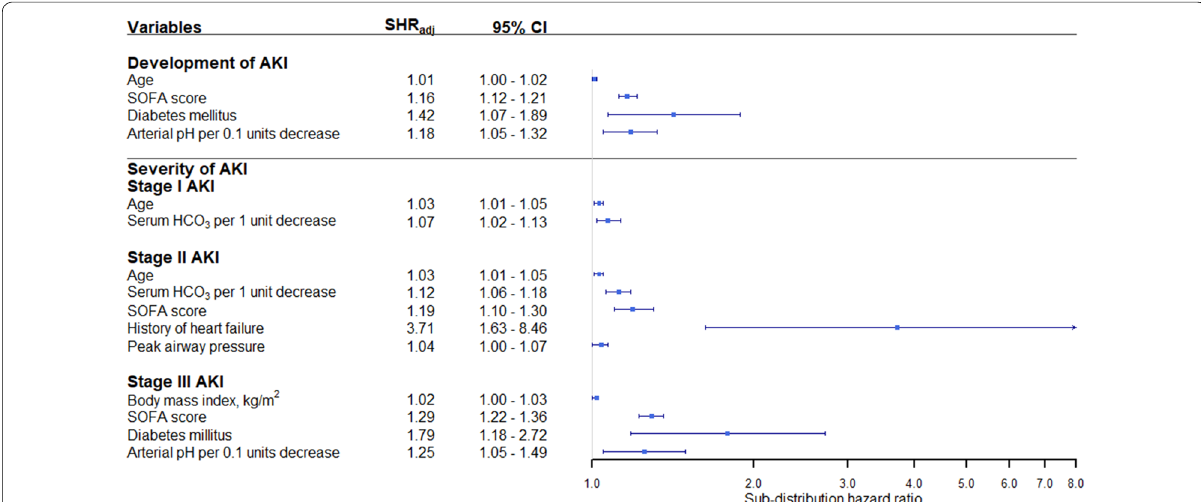
Fig. 2 Forest plot showing the results of multivariable competing risk regression analysis for factors associated with development of acute kidney injury and severity of acute kidney injury. The x‑axis represents the adjusted subdistribution hazard ratio (SHR adj ) on a log scale with the reference line (solid vertical line), adjusted subdistribution hazard ratio (square), and 95% confidence interval